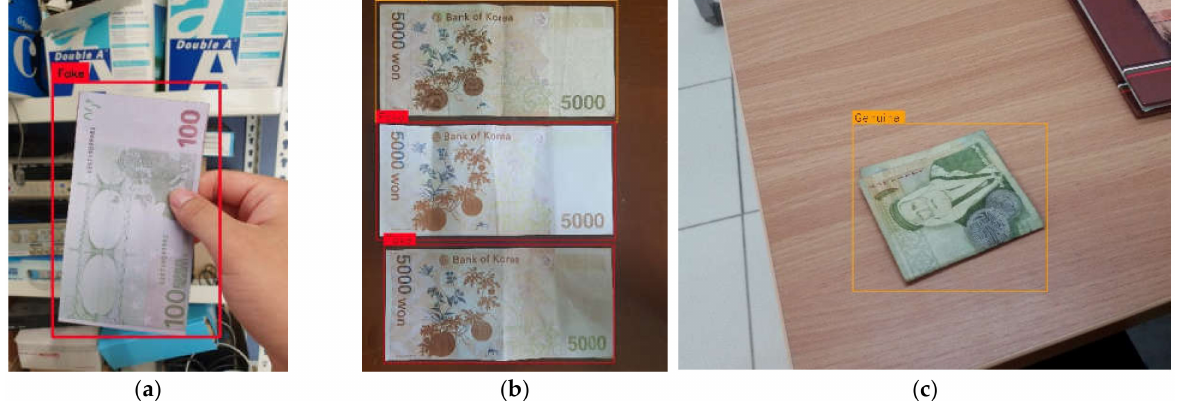
Figure 18. Correctly detected cases of ( a ) a fake EUR note; ( b ) (from top to bottom) genuine and two fake KRW notes; and ( c ) a genuine JOD note using the models trained on the USD